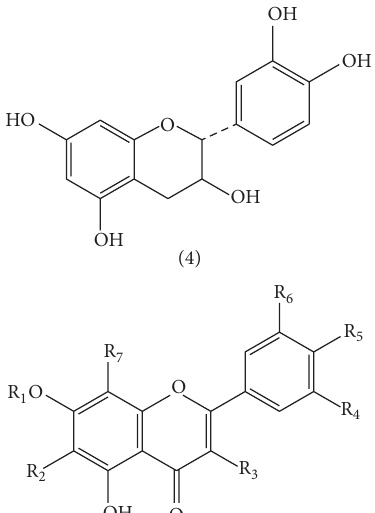
Figure 2: Chemical structure of flavonoids: (4) catechin; (5) quercetin; (6) rutin; (7) baicalein; (8) baicalin; (9) wogonin; (10) oroxylin A; (11) apigenin; (12) kaempferol; (13) hyperoside.